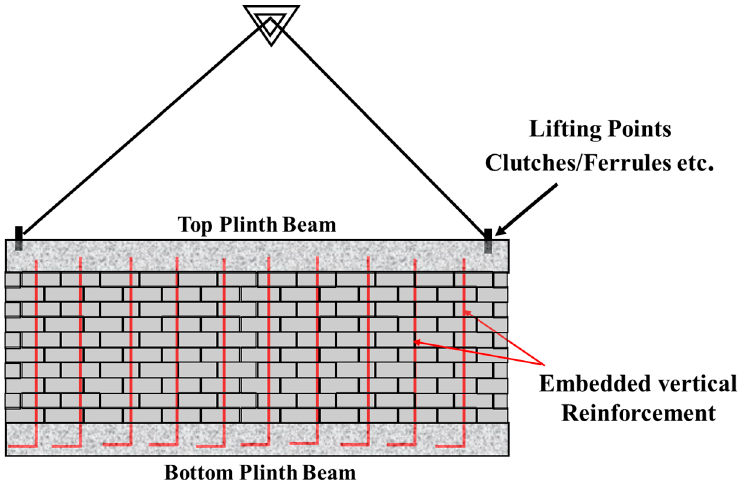
Figure 10. Lifting method of masonry walls.